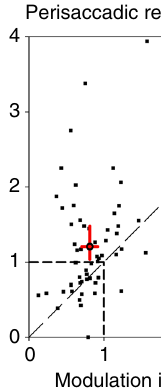
neural activity. The activity levels were modeled after our real data set, i.e., activity distribution across the population was identical to our real data set, with additional noise. Importantly,